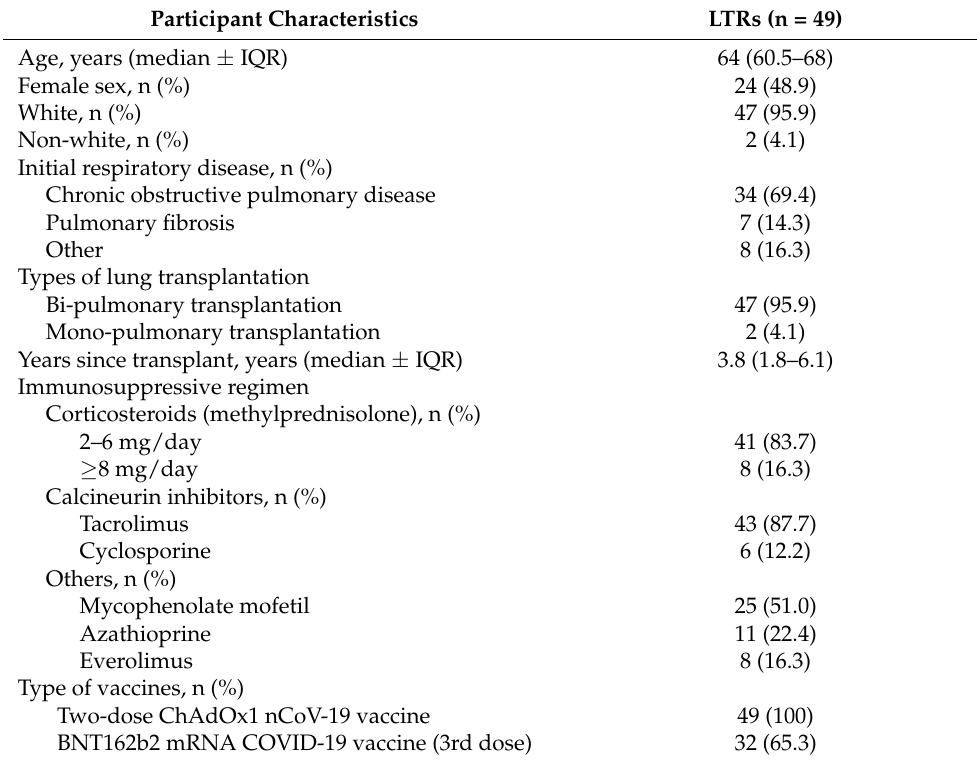
Table 1. Demographic and clinical characteristics of lung transplant recipients